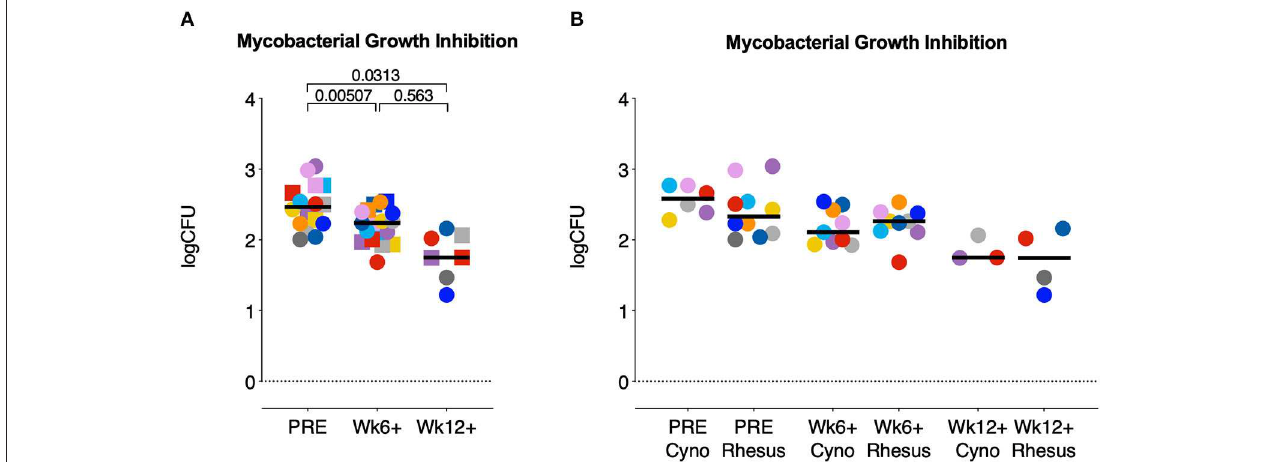
FIGURE 3 | Mycobacterial growth inhibition capacity increases after Mtb infection but does not differ between species. A mycobacterial growth inhibition assay (MGIA) was used to determine the potential of rhesus and cynomolgus PBMC to control mycobacterial growth after infection. Data are depicted relative to individual IGRA conversion time points, for (A) rhesus and cynomolgus together, or (B) for each of the two species separately. Number of animals per time point varied due to sample availability. Horizontal lines indicate group medians. In (A) ; squares represent cynomolgus samples, circles represent rhesus samples. Two-sided Mann-Whitney testing was used to determine significance of differences between groups. Color coding per individual, as defined in Table 1 , is consistently applied